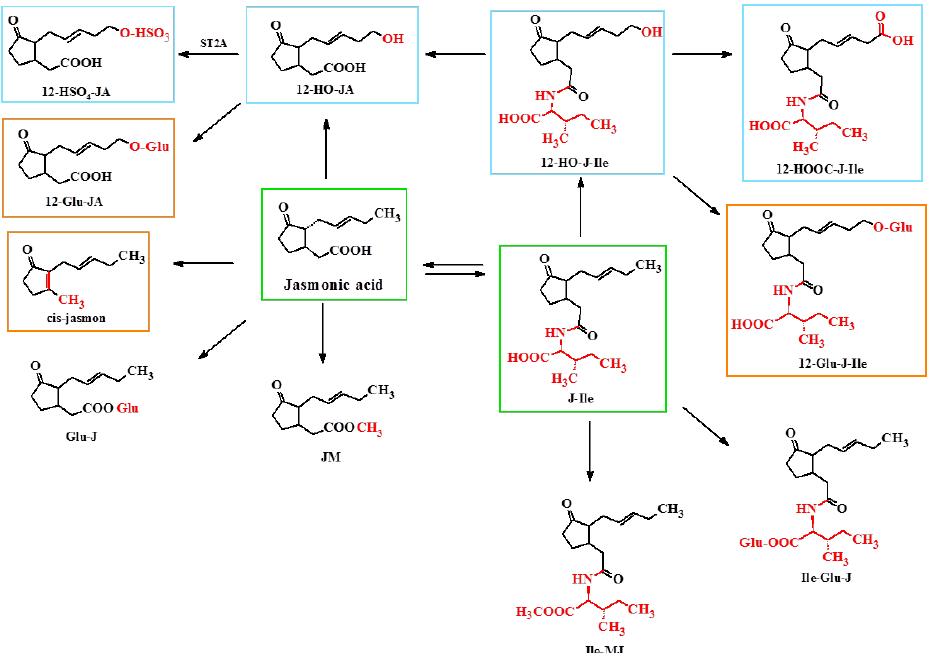
Figure 4. Jasmonic acid derivatives and metabolites; green box = derivatives active, blue box = derivatives inactive, orange box = derivatives partially active. 12-HSO3-JA, 12-bisulfate jasmonic acid; 12-HO-JA, 12-hydroxyjasmononic acid; 12-HO-JIle, (12-hydroxyjasmonoyl)isoleucine; 12-HOOC-J-Ile, (12-carboxyjasmonoyl) isoleucine; 12-Glu-JA, 12-glukozylojasmonic acid; J-Ile, jasmonoylisoleucine; 12-Glu-J-Ile, (12-glukosyljasmonoyl)isoleucine; Glu-J, glukosyl ester of jasmonic acid; JM, methyl ester of jasmonic acid; Ile-JM, methyl ester of jasmonoylisoleucine; Ile-Glu-J, glukosyl ester of jasmonoylisoleucine.